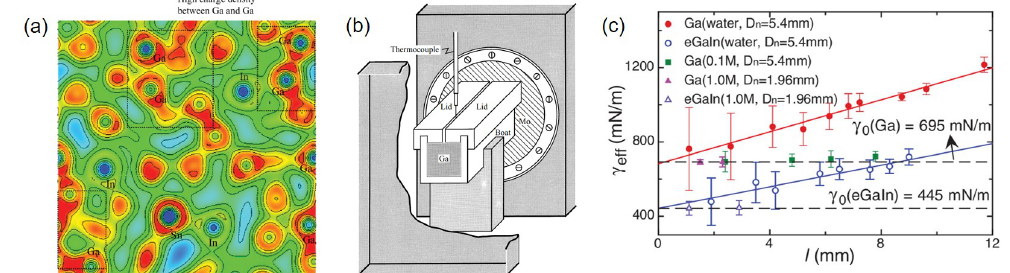
Figure 1. ( a ) A contour of charge density for liquid EGaInSn at 310 K. The color scale is from 0 (blue) to − 3 0.038 (red) e c Å . Reprinted from [19], with the permission of AIP Publishing. ( b ) A schematic of the experimental apparatus for measuring thermal conductivity of gallium. Reproduced with permission from [13]. ( c ) Measured effective surface tension vs. drop diameter, l , for gallium and EGaIn in water or HCl baths with different concentrations. Reprinted from [25], with the permission of AIP